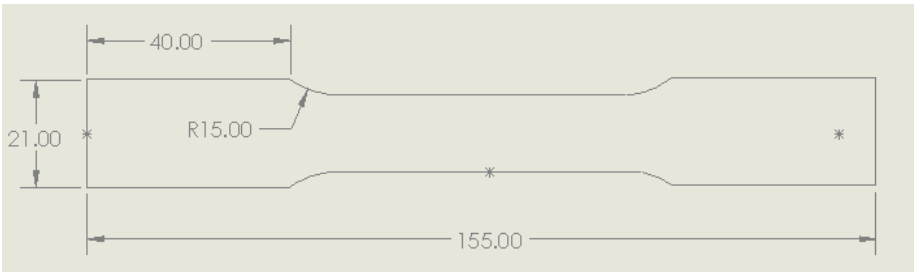
Figure 10. The schematic diagram of DP 980.